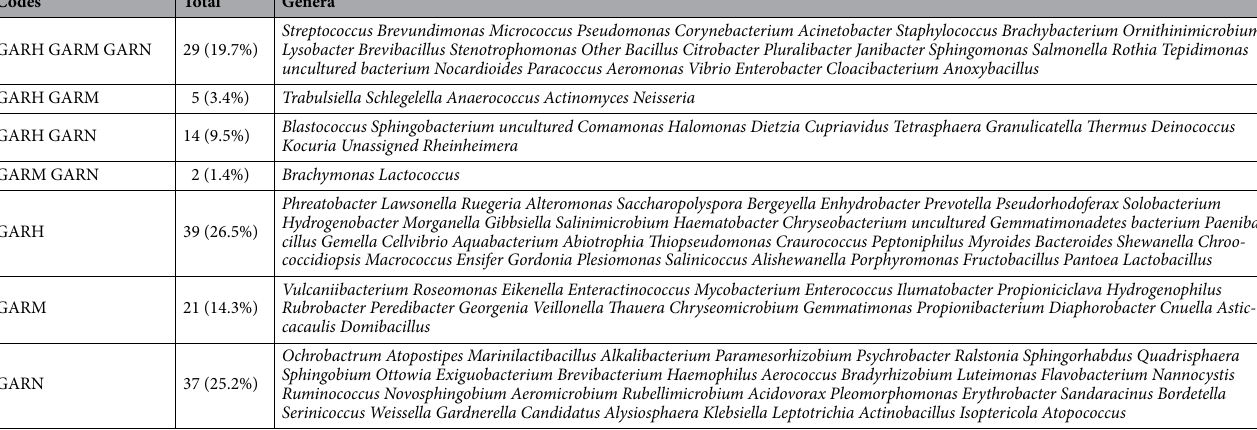
Table 2. Composition of the core microbiome according to R. microplus sex and stage